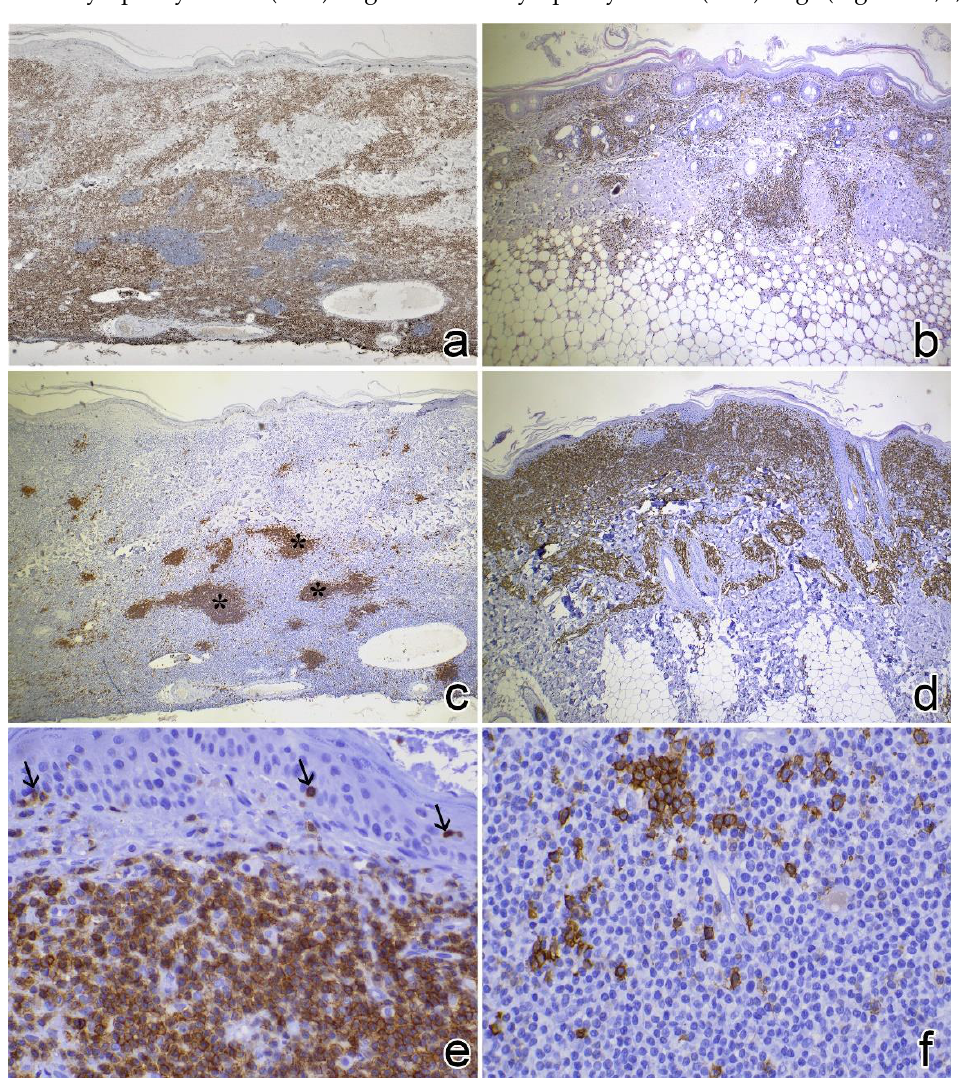
Figure 4. Immunohistochemical findings of feline and canine lymphocytosis (peroxidase method). ( a ) Cat no. 3: infiltrating cells are diffusely positive with the anti-CD3 antibody (40×). ( b ) Dog no. 8: infiltrating cells are diffusely positive with the anti-CD3 antibody (40×). ( c ) Cat no. 3: deep nodular aggregates of lymphocytes (asterisks) are positive for the anti-CD20 antibody (B lymphocytes) (40×). ( d ) Dog no. 6: infiltrating cells are diffusely positive with the anti-CD20 antibody for B lymphocytes (40×). ( e ) Cat no. 6: lymphocytes are diffusely positive for anti-CD3 antibody, note the scant epitheliotropism (black arrows, 400×). ( f ) Dog no. 3: CD3+ T lymphocytes are present, single or in small aggregates (400×).